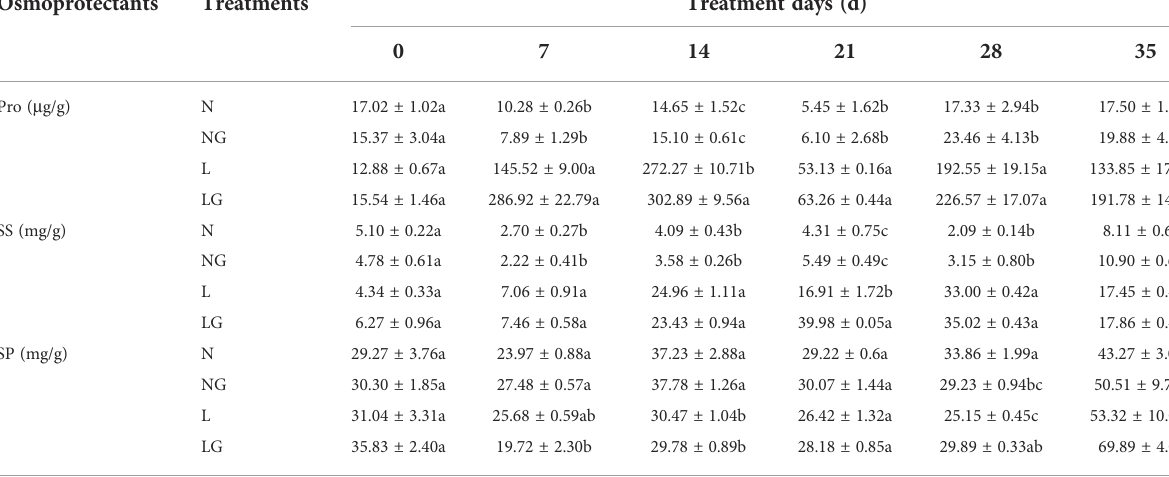
TABLE 1 Effects of GABA spraying on osmoprotectants in M. ruthenica seedlings on different treatment days. Osmoprotectants